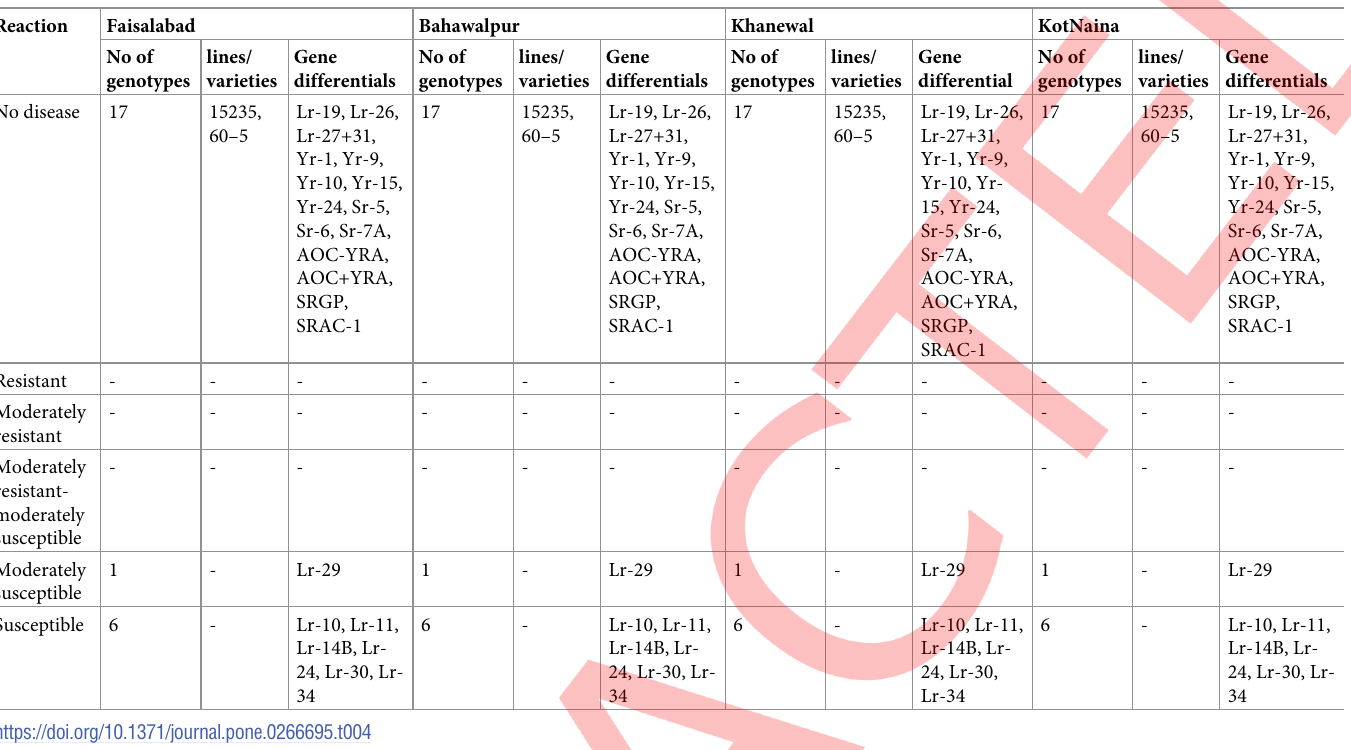
Table 4. Genotypes resistant to leaf rust at all locations during